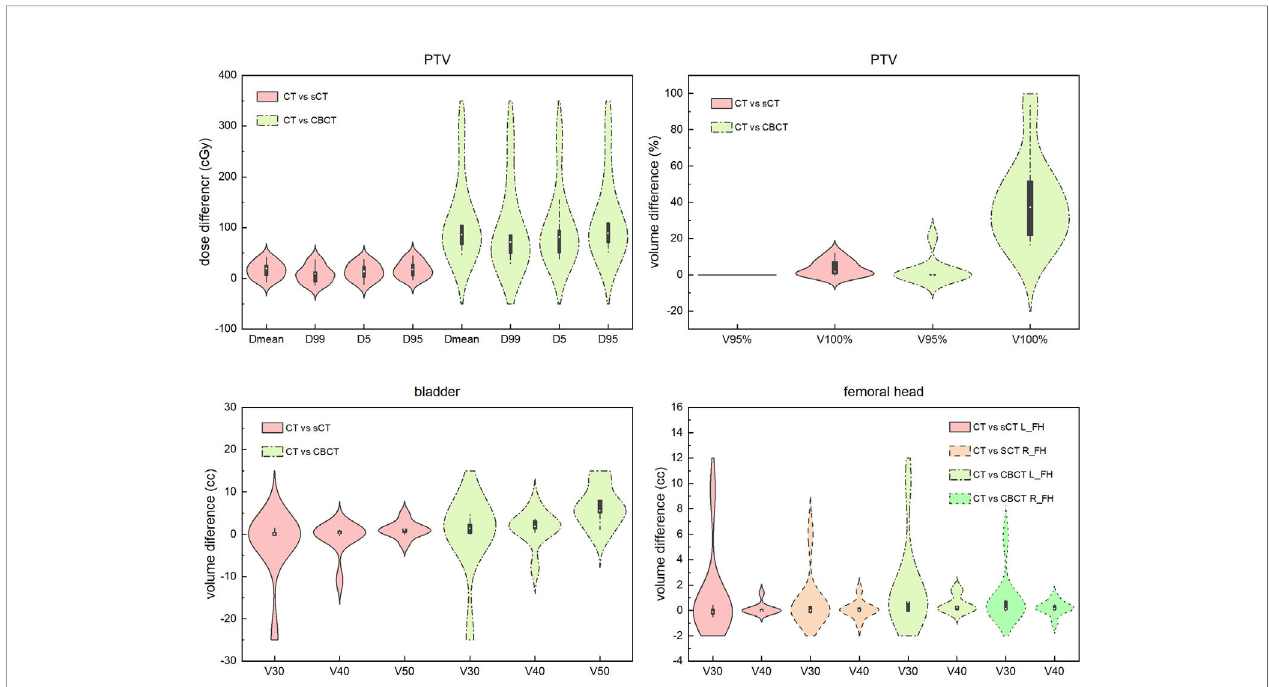
FIGURE 7 | Dosimetric difference comparisons of sCT- and CBCT-based plans with CT-based plans for PTV, bladder and the femoral head. Dmean represents the mean dose to the volume. Dx represents the dose to x% of the volume. Vx% represents the volume receiving at least x% of the prescribed dose. Vx represents the percentage of volume receiving xGy dose. L_FH and R_FH means left femoral head and right femoral